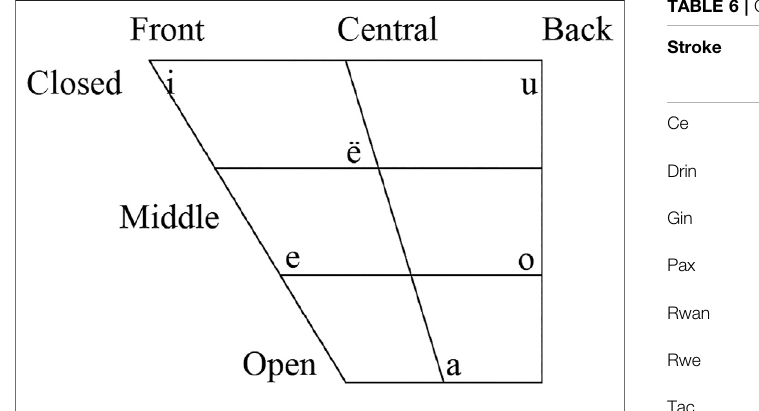
FIGURE 1 | Chart with the used